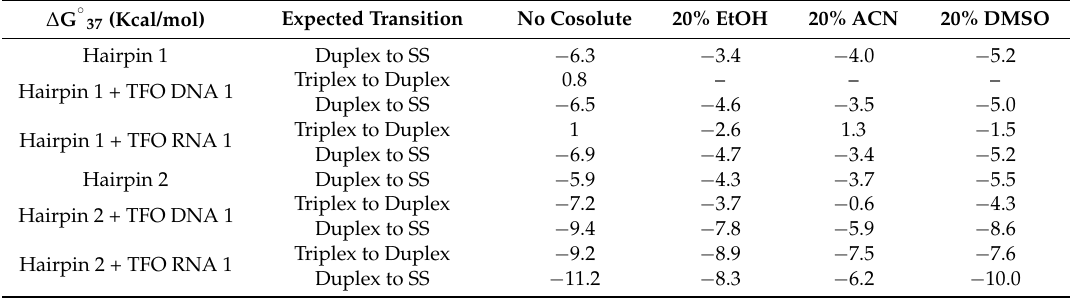
Apparent thermodynamic parameters ( ∆ G ˝ 37 , Kcal/mol) calculated from thermal denaturation curves of hairpin duplex and the expected triplexes formed with hairpin and DNA- or